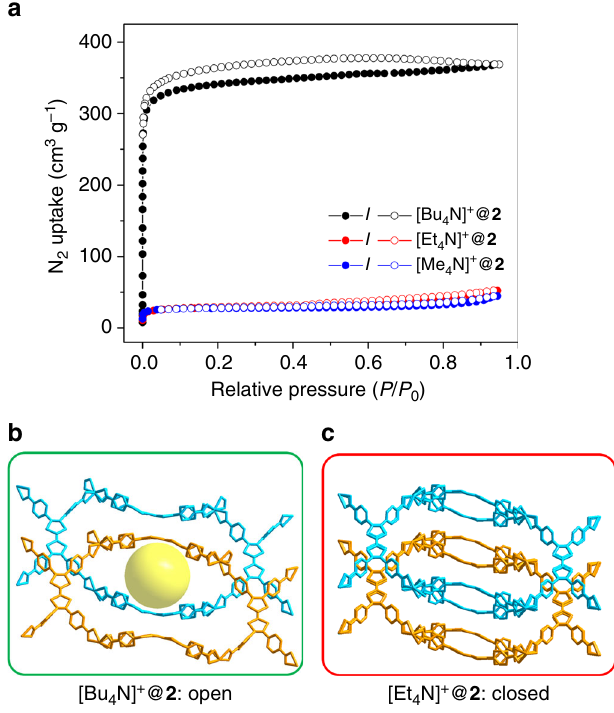
Fig. 5 Effects of cations. a N 2 sorption isotherms of [Bu 4 N] + @ 2; b N 2 sorption isotherms of [Et 4 N] + @ 2 ; c N 2 sorption isotherms of [Me 4 N] + @ 2 . Two sets of interpenetrated networks were colored blue and orange. The cavity is highlighted by the yellow